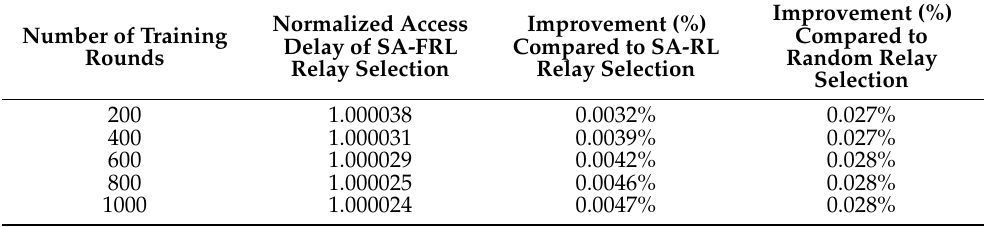
Table 6. Normalized access delay of SA-FRL with different amount of pre-training data, experimental